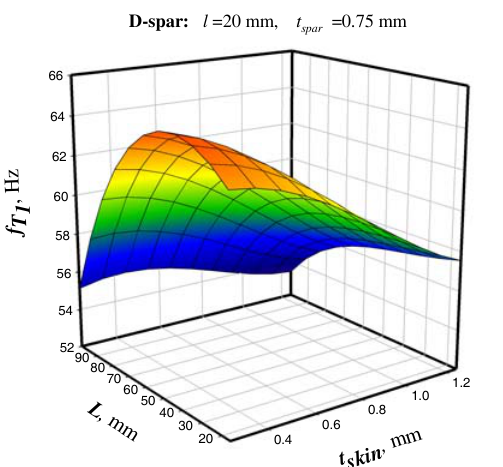
Fig 20. The dependences of first torsion frequency on MFC chord-wise length and skin thickness The dependencies of center of gravity location on MFC chord-wise length and skin thickness are given in Fig 21.